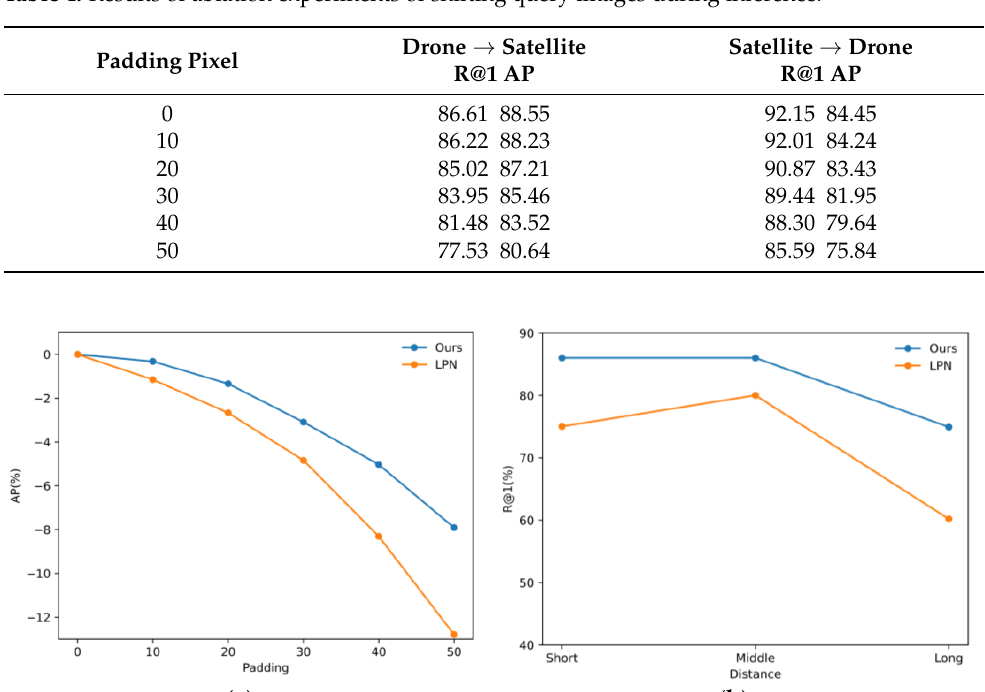
Table 4. Results of ablation experiments of shifting query images during inference.